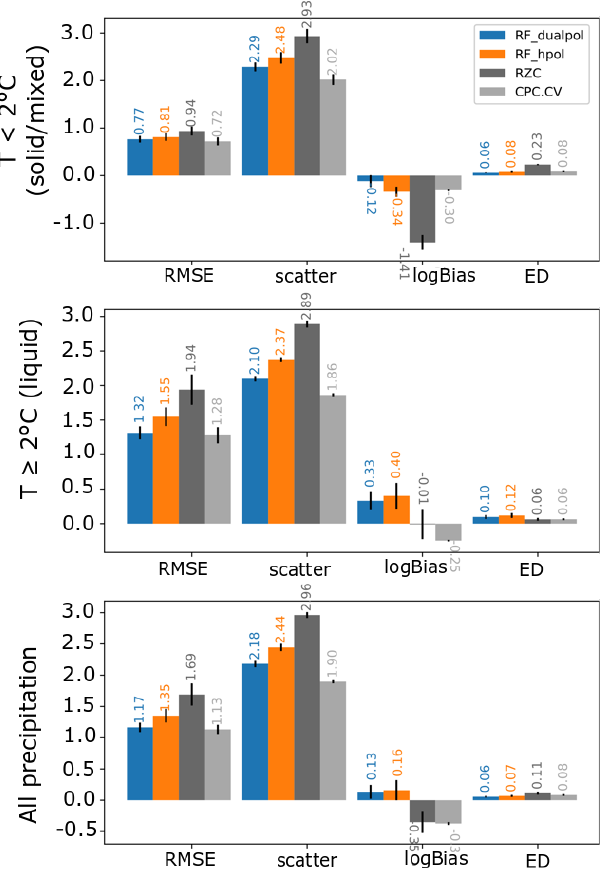
Figure 8. Overall performance metrics of the fitted RF models and the references for a five-fold cross-validation. The small black lines at the center of the bars indicate the standard deviation of the metrics over the five-fold